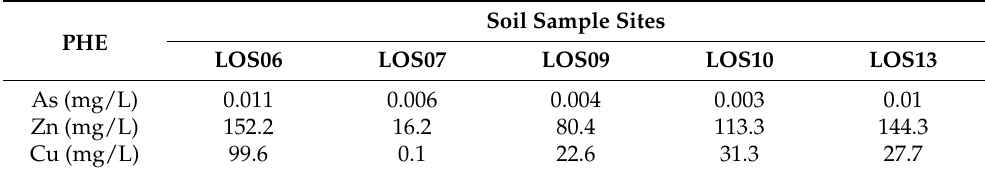
Soil Sample Sites